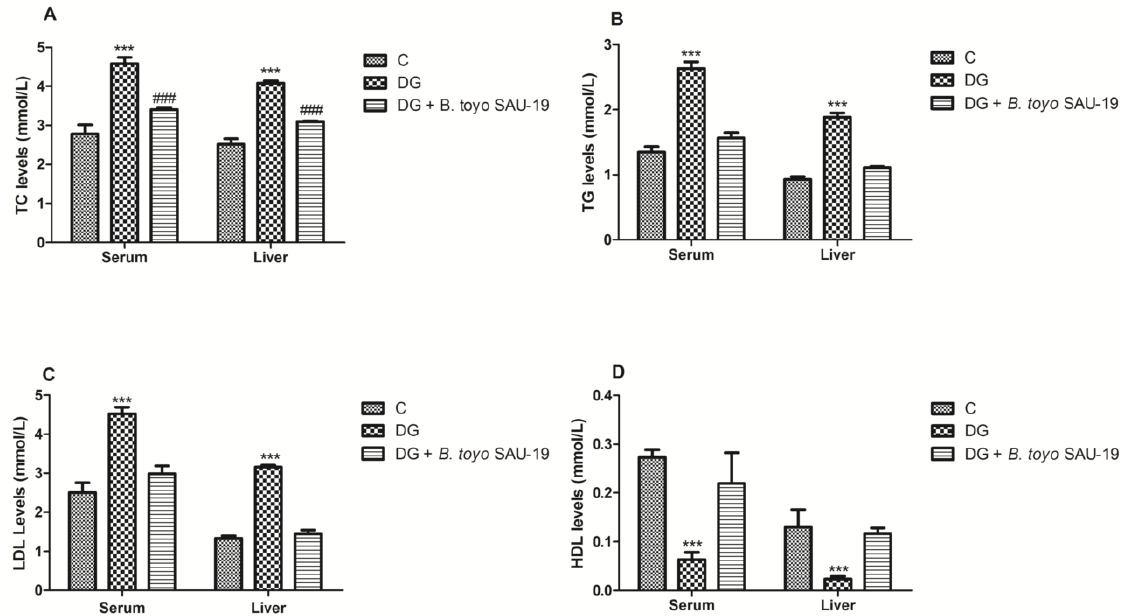
Figure 4. Effects of Bacillus toyonensis SAU-19 on lipid profiles in HFD/STZ-induced T2DM mice. ( A ) Levels of TC in blood and liver serum (mmol/L). ( B ) Levels of TG in blood and liver serum (mmol/L). ( C ) Levels of LDL-C in blood and liver serum (mmol/L). ( D ) Levels of HDL-C in blood and liver serum (mmol/L). ( E ) Glycogen content in liver (mg/g tissue). Values are shown as mean ± Sd. *** p < 0.05, DG compared with the control (C) and B. toyo SAU-19 groups. ### p < 0.05, B. toyo SAU-19 compared with the control (C) group ( n = 6). TC — Total cholesterol, TG — Triglyceride, LDL-C — Low-density lipoprotein cholesterol, HDL-C — High-density lipoprotein cholesterol.